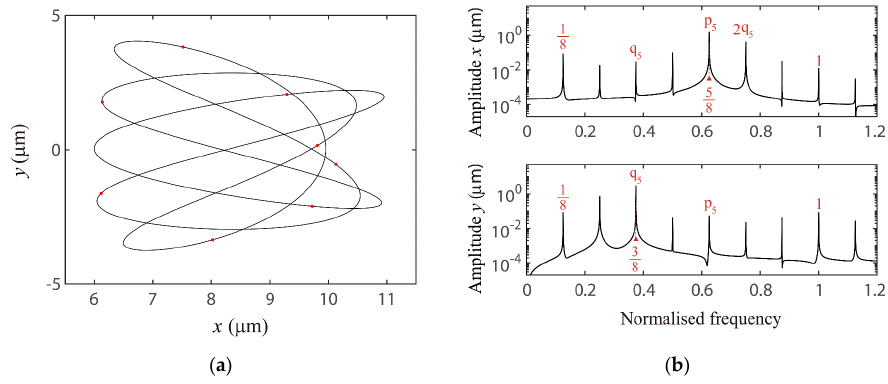
Figure 20. For δ 0 = 4.0 μ m, response characteristics of the VC period-8 motion when Ω = 355 rad/s, ( a ) orbit (black line) and its Poincare mapping (red dots), ( b ) frequency spectrum. Table 5. The equivalent resonant frequencies of the system predicted from Equation (23).